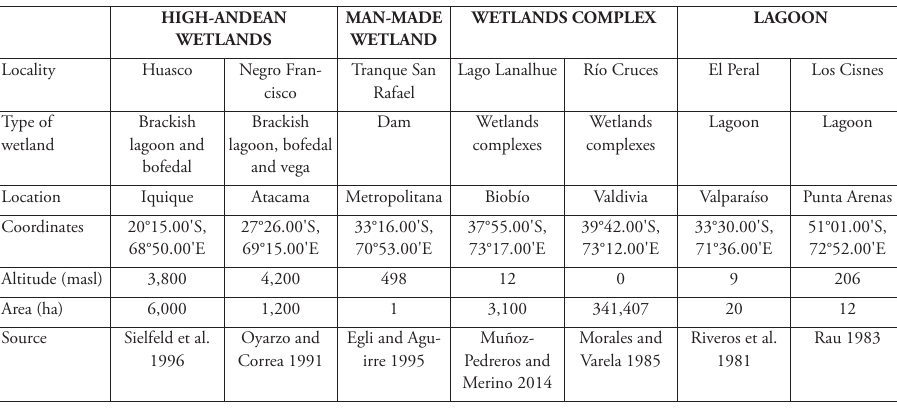
Table 3. Characterisation of seven inland wetlands in Chile.